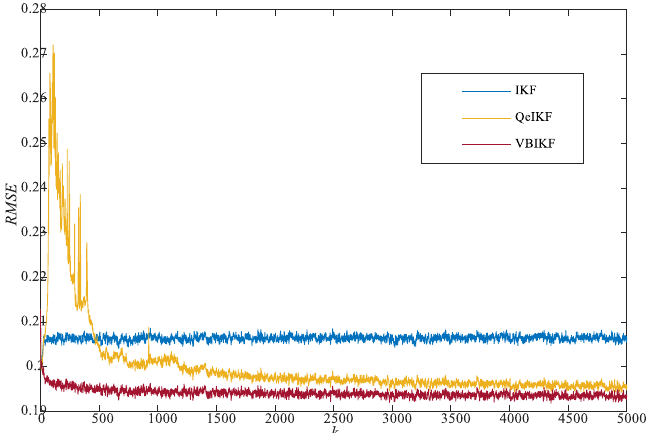
Figure 6. The RMSE result of the IKF, the QeIKF, and the VBIKF for the scaled ˆ Figure 6. The k